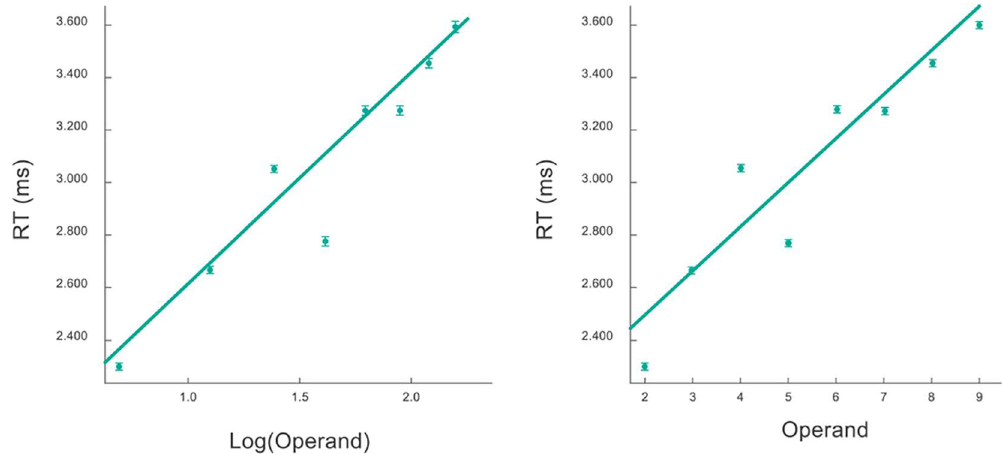
bars are barely seen due to the large numberof collecteddata.